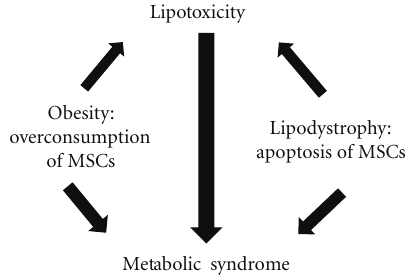
Figure 4: Metabolic syndrome in obesity and lipodistrophy.